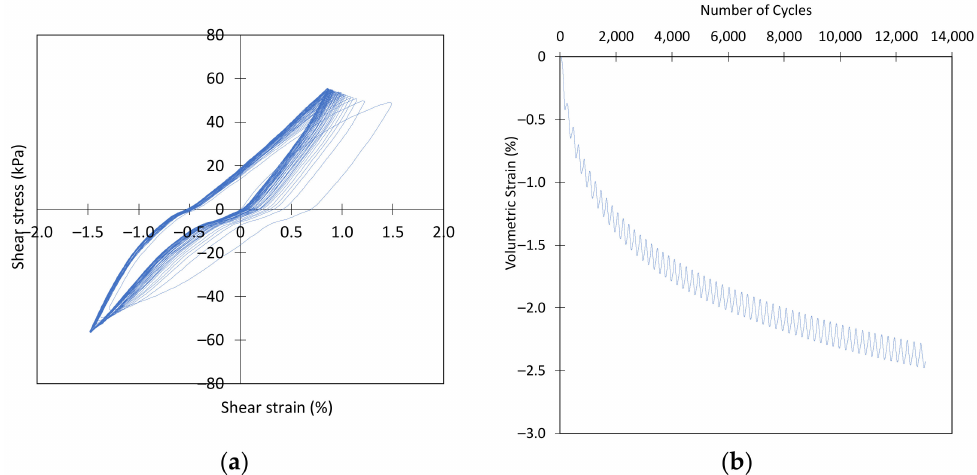
Figure 7. Results of the cyclic tests for CSR = 0.3 and vertical stress = 150 kPa: ( a ) shear stress–strain hysteresis loops; and ( b ) volumetric strain by number of